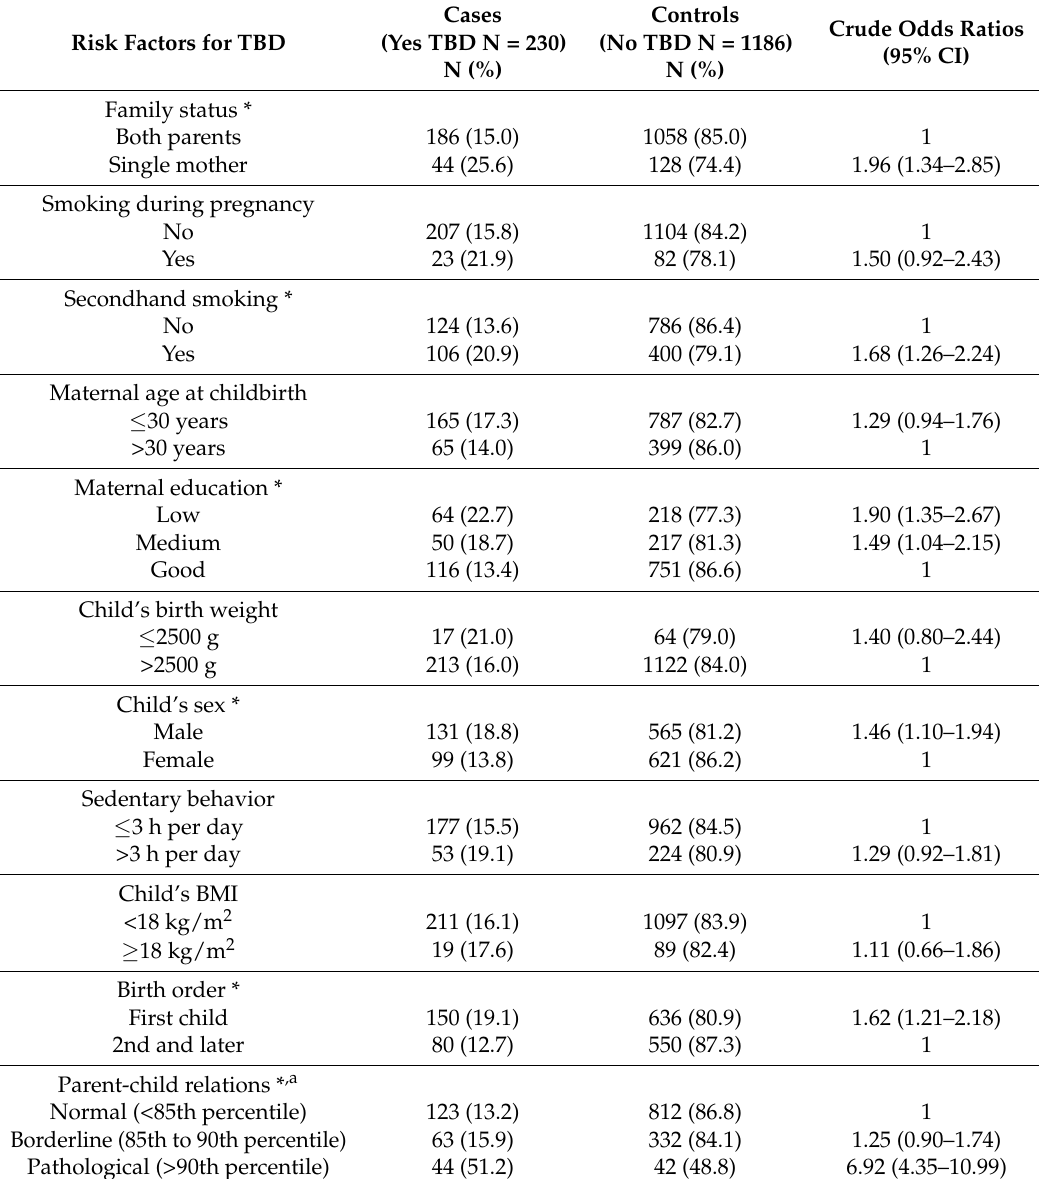
Table 2. Prevalence of risk factors for children’s total behavioral difficulties (TBD), crude odds ratios, and their 95% confidence intervals